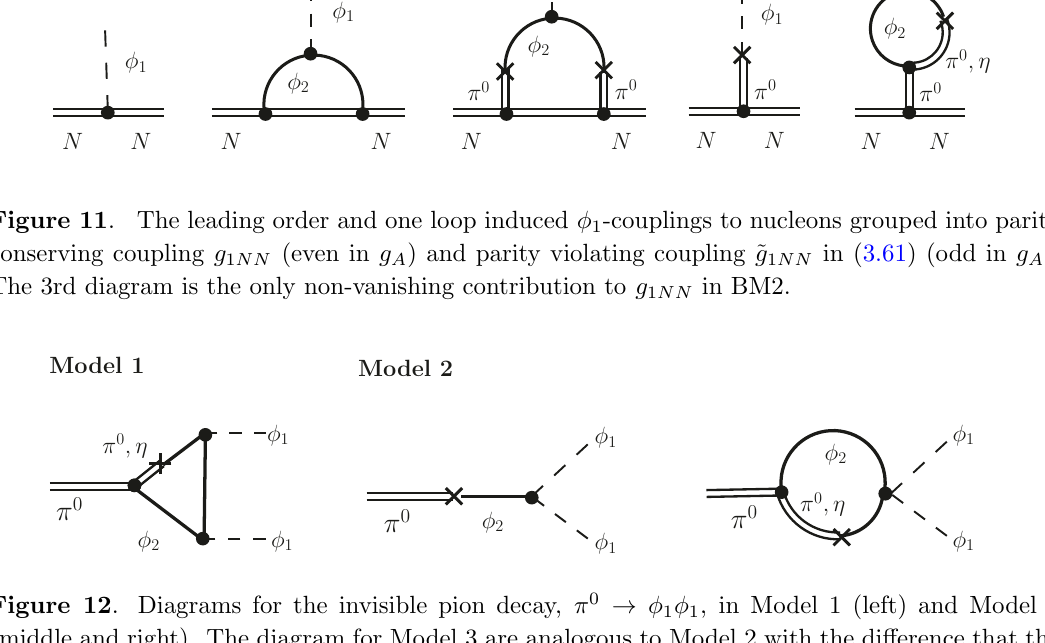
Figure 12 . Diagrams for the invisible pion decay, (cid:25) 0 (middle and right). The diagram for Model 3 are analogous to Model 2 with the di(cid:11)erence that the graph on the right needs an extra 2 propagator as in (cid:12)gure